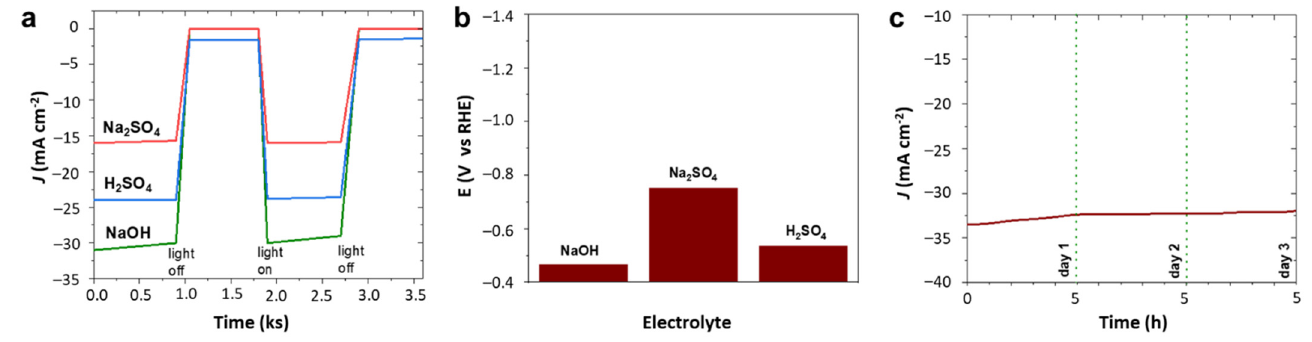
Figure 5. ( a ) Chopped chronoamperometry at − 1.16 V (RHE). ( b ) Potential at − 10 mA cm − 2 current density. ( c ) Chronoamperometry in 0.1 M NaOH at − 1.16 V (vs. RHE) for 4Ir1Ni@ AC catalyst.